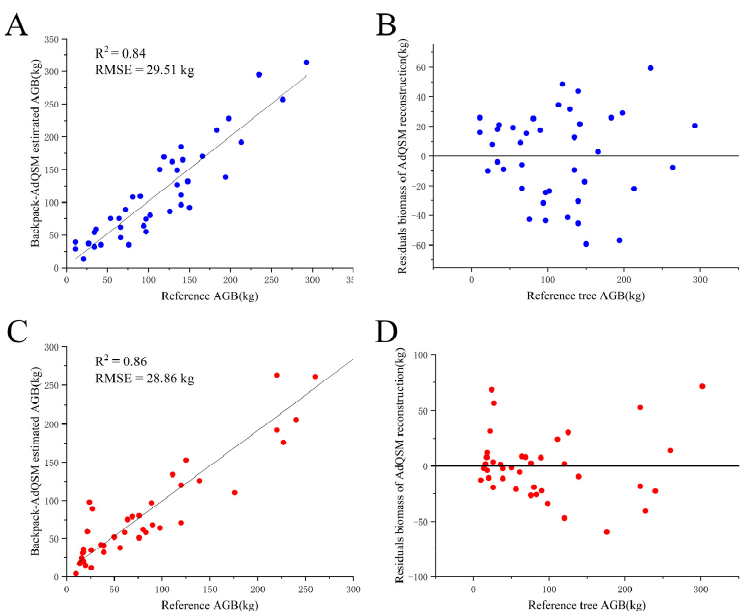
Figure 8. Comparison of AGB results based on the backpack–AdQSM estimates with those calcu- lated by the allometric biomass models. ( A , B ) Comparison of estimated individual tree AGB of Larix gmelinii with reference values and residual distributions. ( C , D ) Comparison of estimated individual tree AGB of Betula platyphylla with reference values and residual distributions, respectively.